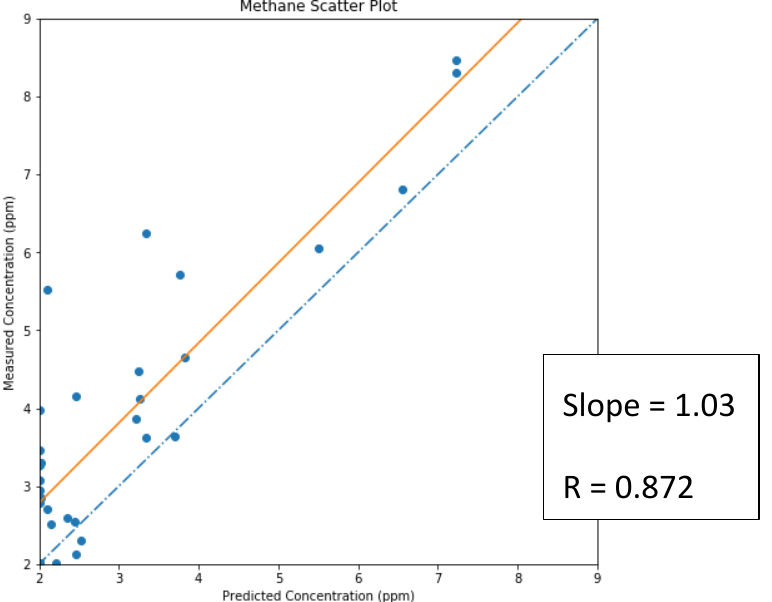
Figure 4. Scatter plot of measured methane concentrations versus modeled concentrations for 5 June 2021, 7:10 a.m. to 7:27 a.m. R denotes the correlation coefficient. The (orange) regression and (blue) 1:1 lines are also displayed.